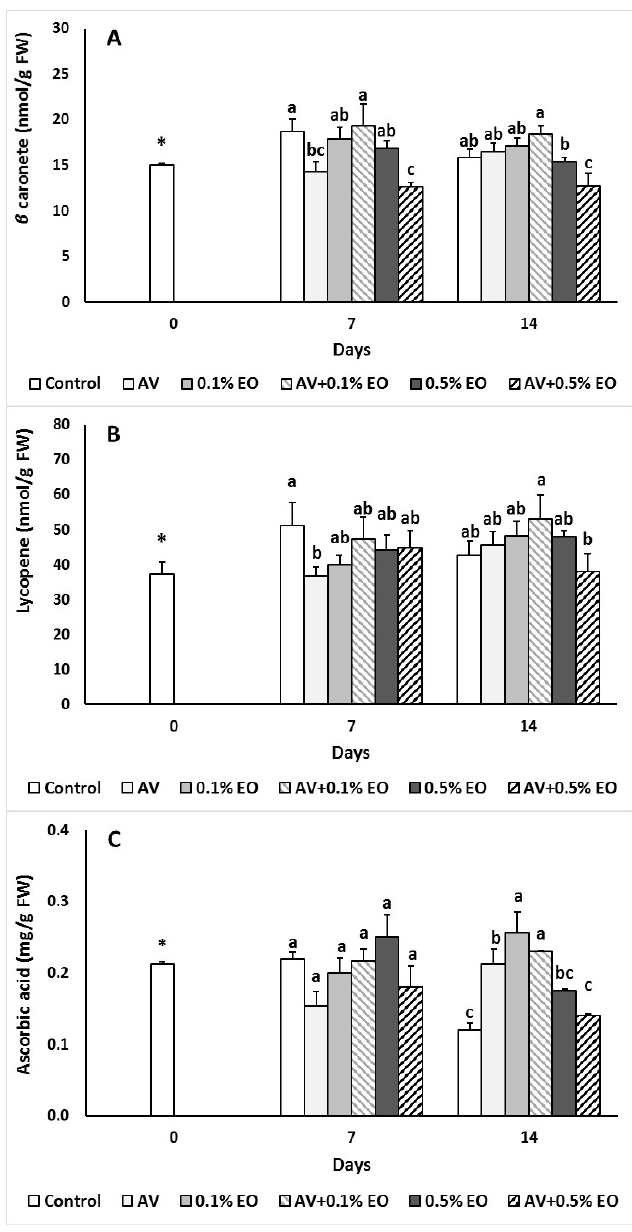
Figure 4. Impacts Aloe vera (AV at 10%) coating and/or sage essential oil (EO at 0.1% and 0.5%) on ( A ) β -carotene (nmol/g FW), ( B ) lycopene (nmol/g FW) and ( C ) ascorbic acid (mg/g FW) in tomato fruit following storage for 7 and 14 days. Fruit were maintained throughout at 11 °C and 90% RH. Values represent mean (±SE) of measurements made on eight independent fruit per treatment and storage period. On the columns, significant differences ( p < 0.05) among treatments are indicated by different Latin letters for different days. Symbols of * or ns indicating significance or not, respectively, among controls through storage period.